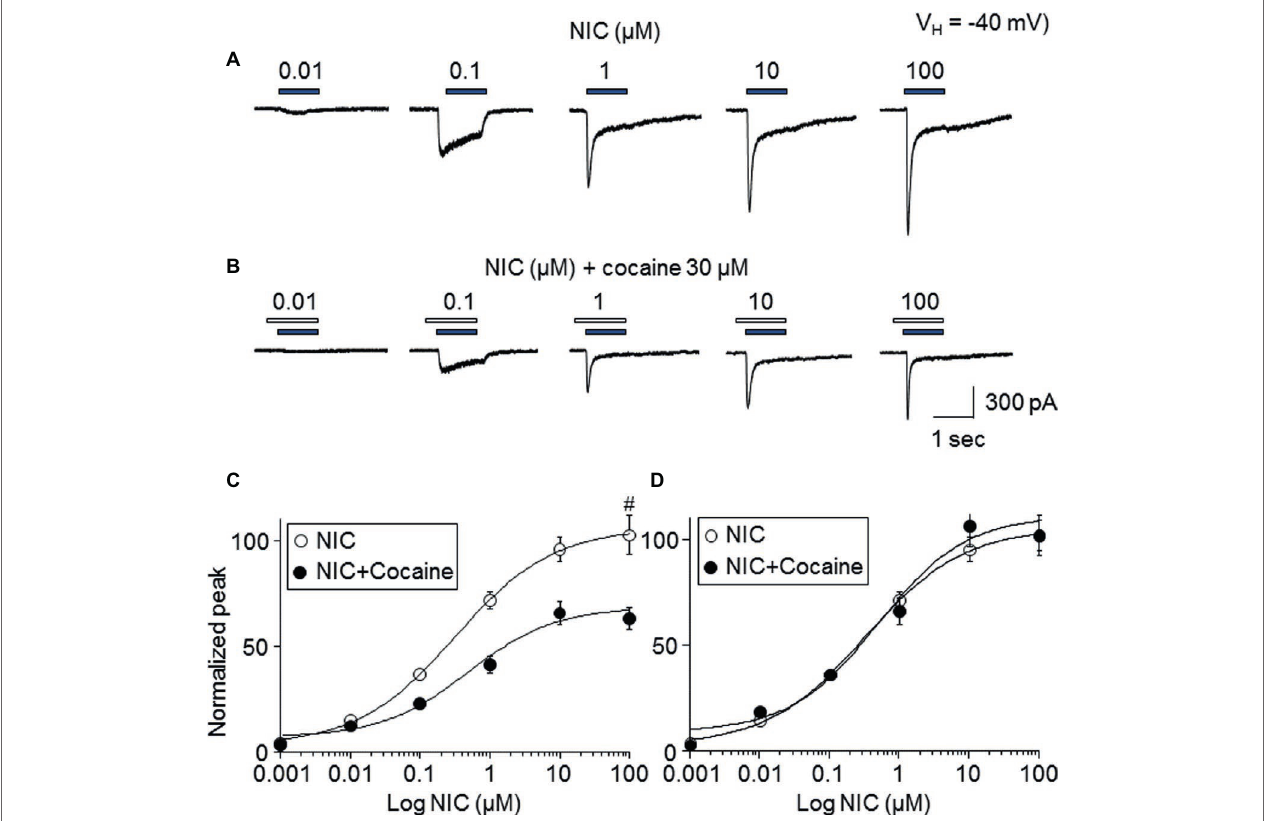
FIGURE 4 | Effects of cocaine on different concentration NIC-induced currents. (A) Typical traces showed NIC alone with different concentration-induced inward currents. (B) Typical traces showed 30 μ M cocaine (with 1 min pretreatment) plus NIC with different NIC concentration-induced inward currents. Panels (A,B) were recorded from the same cell. (C) Sigmoidal NIC concentration-response curves without (open circle) and with (filled circle) 30 μ M cocaine. All symbols were normalized to NIC 100 μ M-induced current (indicated as #). (D) Sigmoidal NIC concentration-response curves without (open circle) and with (filled circle) 30 μ M cocaine. Two group data were normalized to their own maximal NIC concentration (100 μ M)-induced